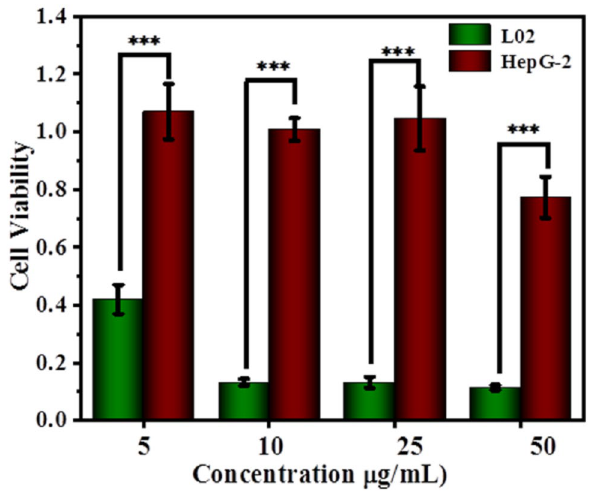
Figure 4. CCK8 results about the HepG-2 and L02 cells incubated with PhIP aerosols for 24 h with varied concentration from 5 to 50 μg/mL, 200 μL, respectively. The results were given as a mean value of three independent experiments ± SD. The statistical analysis was performed by the one-way analysis of variance- ANOVA followed by Turkey’s post hoc test (* p < 0.05, ** p < 0.01, *** p < 0.001).